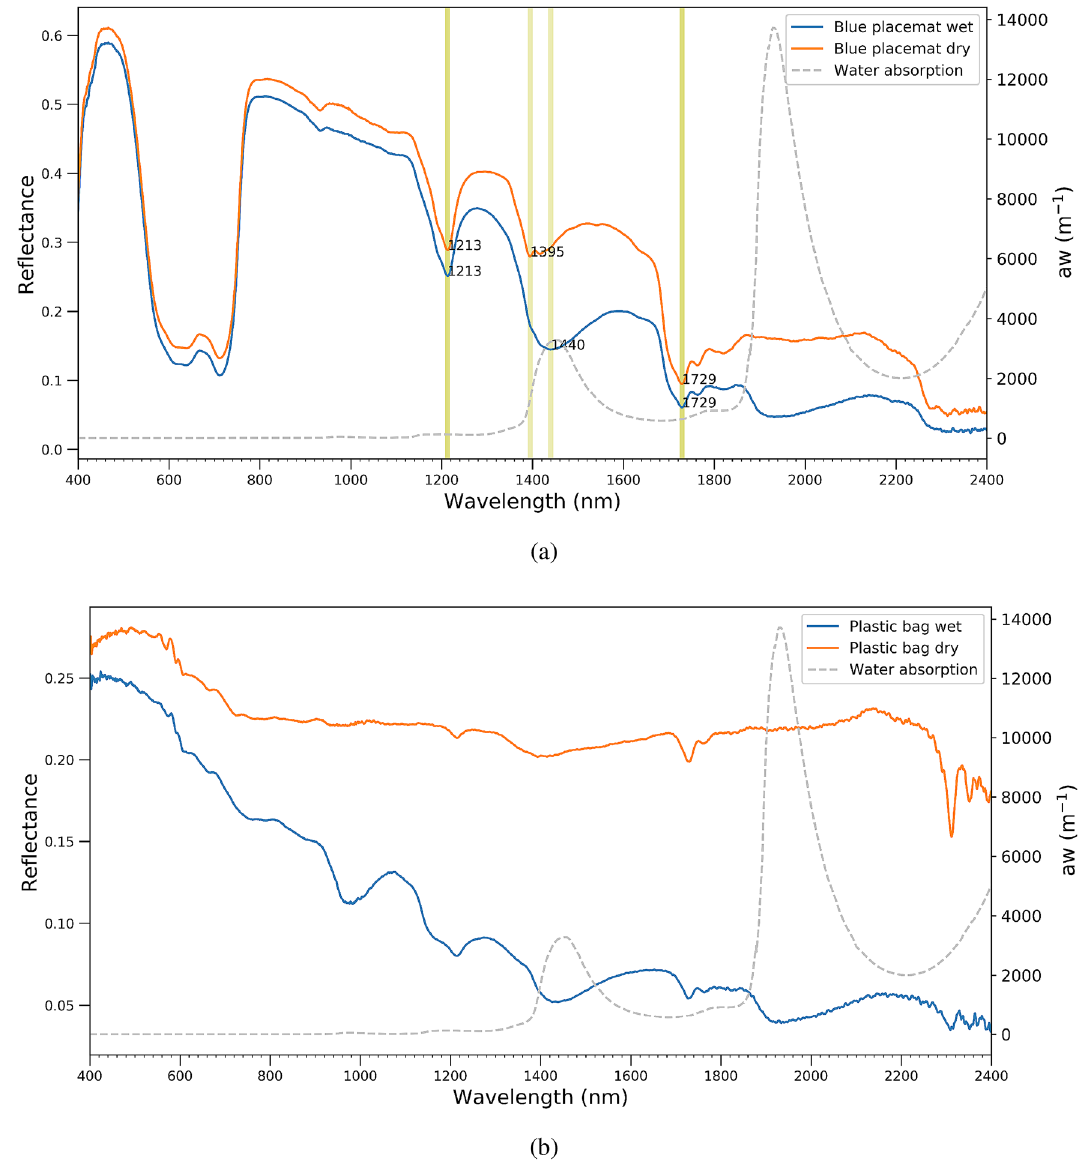
Figure 3. Absorption coefficient of pure water 30,33 and spectral reflectance of ( a ) dry and wet placemats ( b ) dry and wet plastic bag.